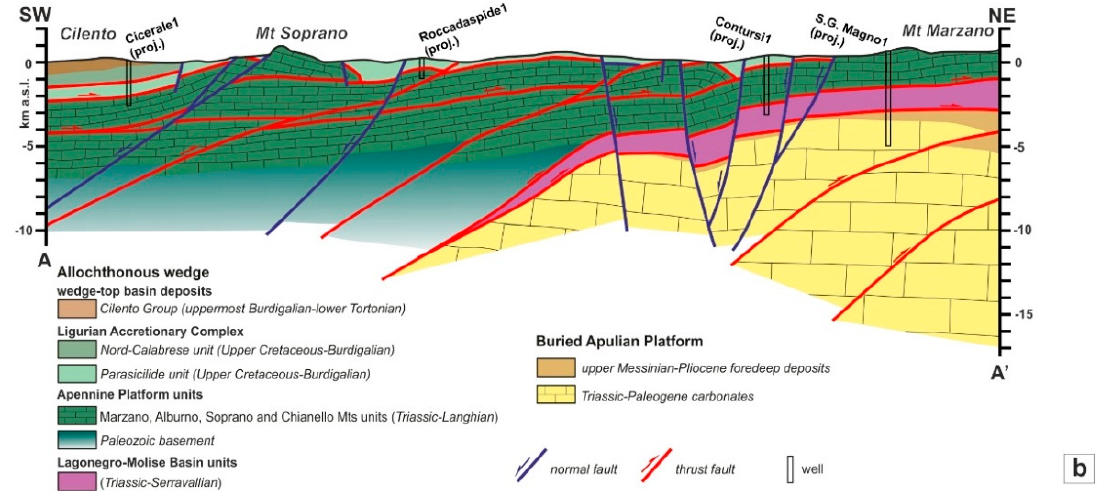
Figure 1. ( a ) Schematic geological map of the southern Apennines. ( b ) Geological cross-section. ( a , b ) modified after [8].